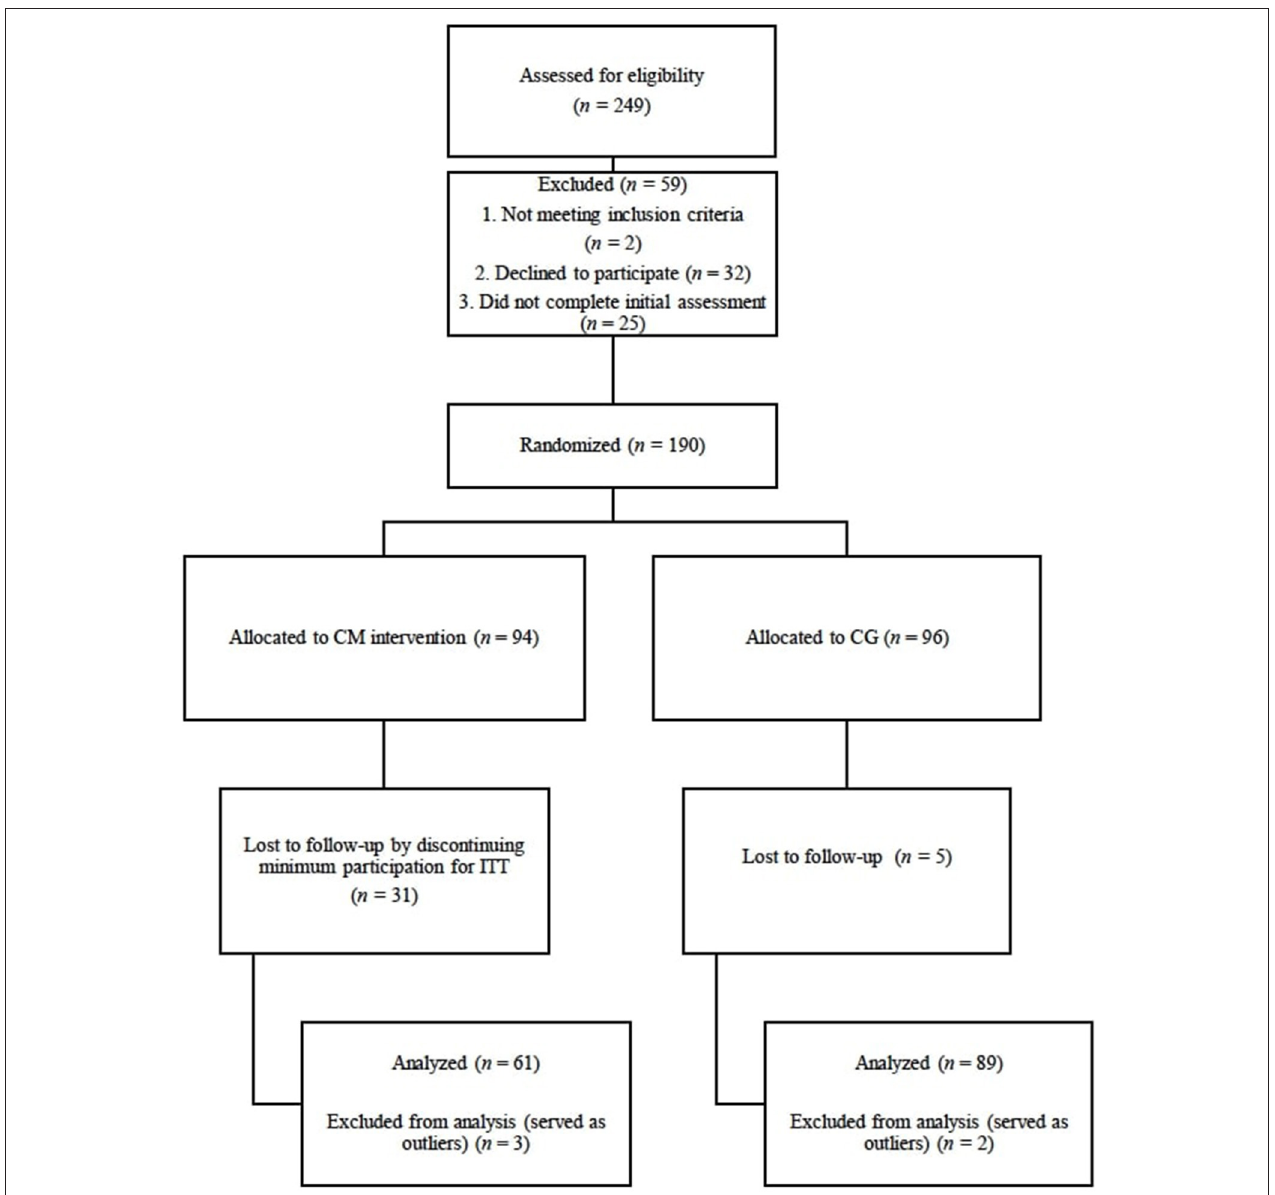
FIGURE 1 | Participant CONSORT flow diagram through the study. CM, centering meditation; CG, comparison